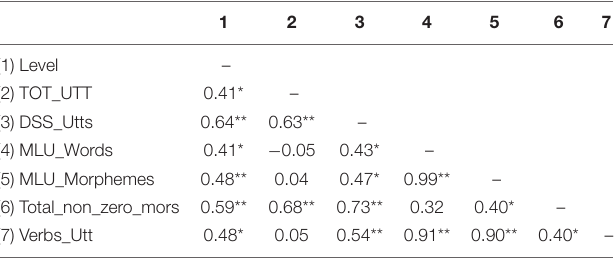
TABLE 3 | Correlations between syntactic indices and grade level.